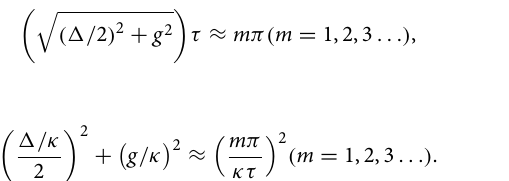
10 , the interaction = 1.93 µ s and φ π/ 2 . Hyperradiance region is inside the black = =